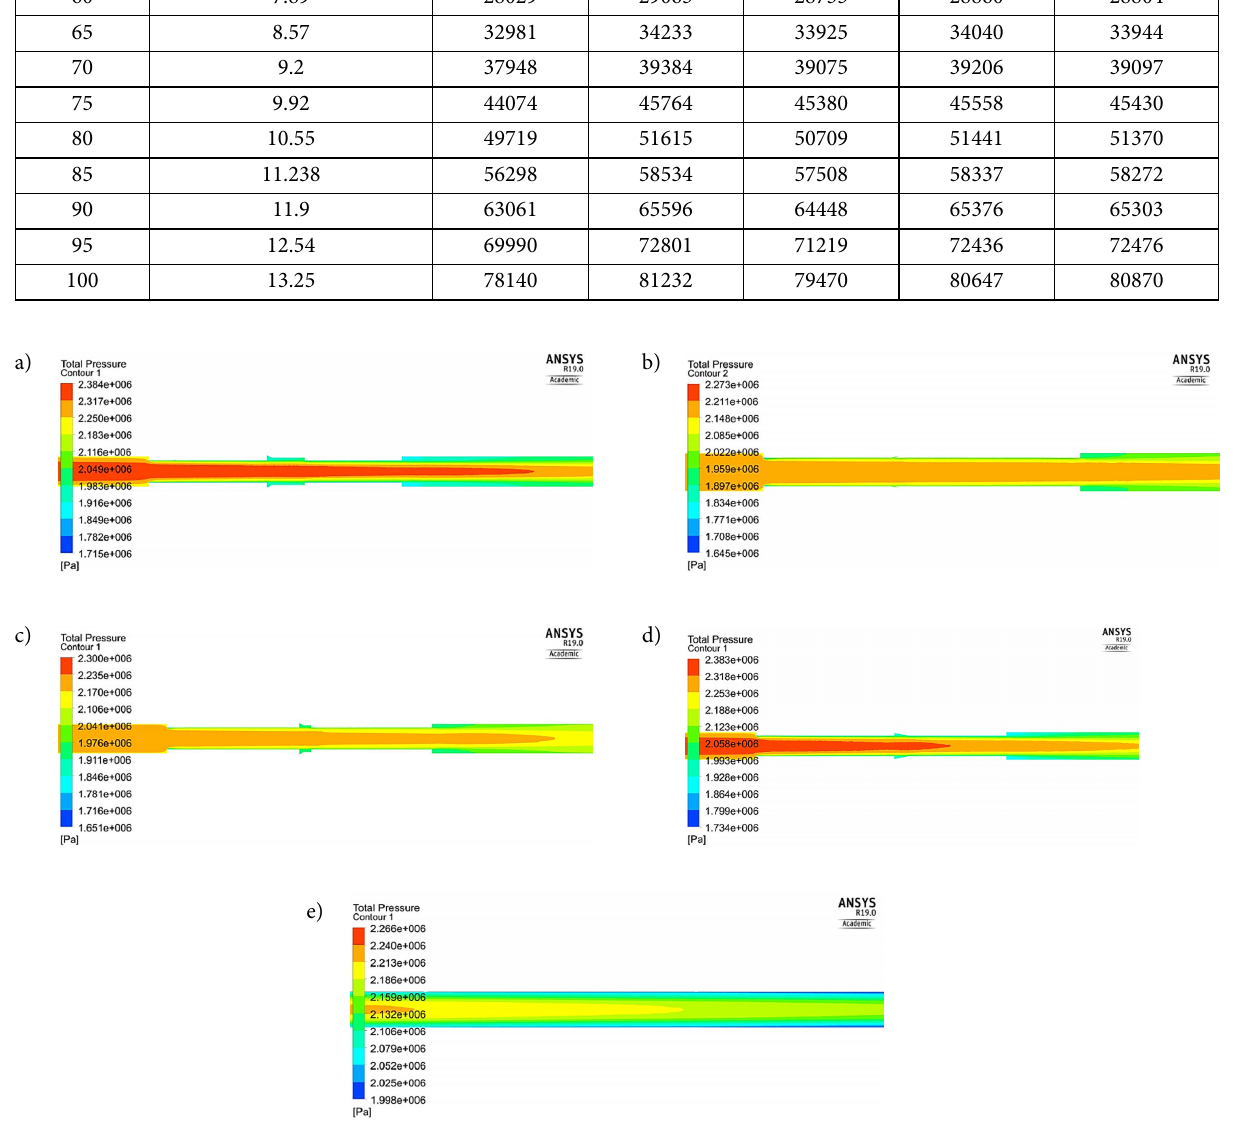
Figure 10. Total fluid pressure across fitting connections (by fluent simulation): a – BSP fitting connection; b – JIS fitting connection; c – DKOL fitting connection; d – ORFS fitting connection; e – straight pipeline of the equivalent